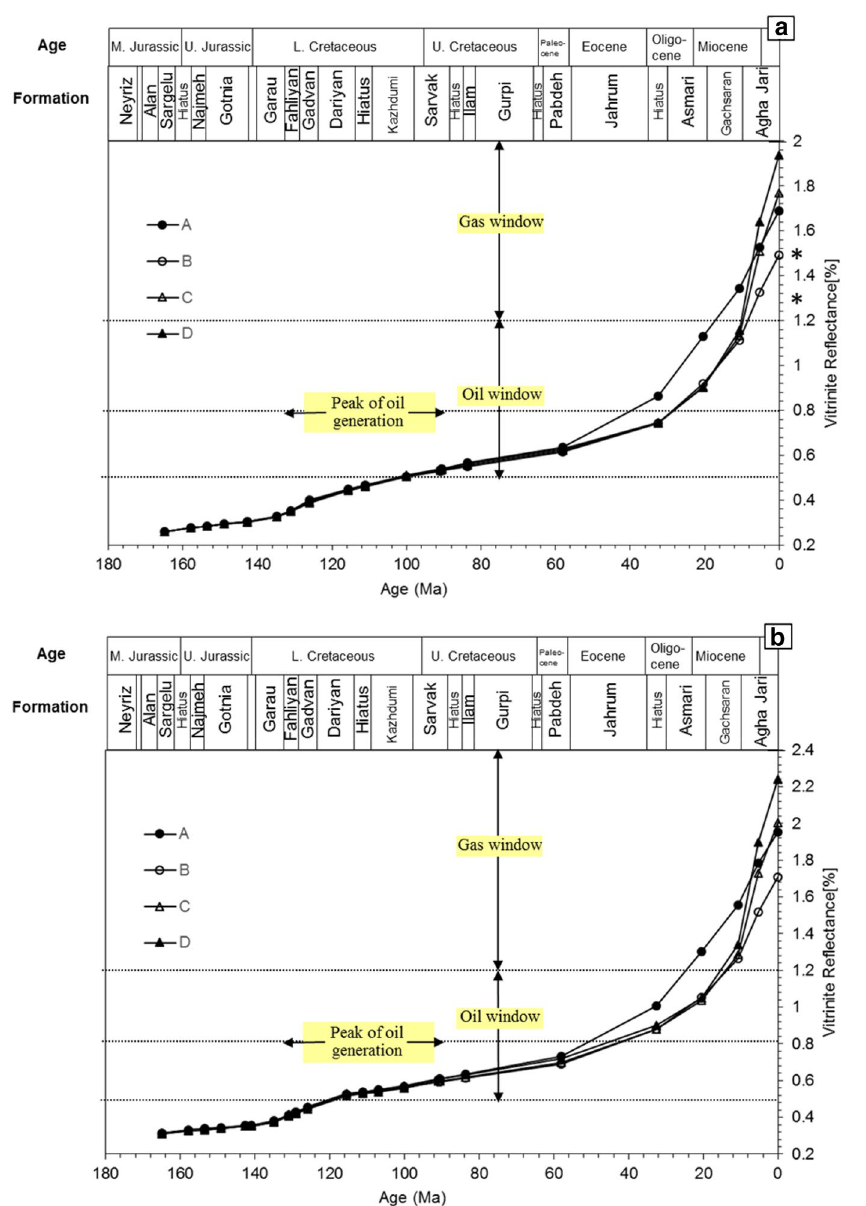
Fig. 15 Maturity history of the Sargelu ( a ) and Neyriz ( b ) source rocks for Wells A, B, C, and D (*measured vitrinite reflectance data from Well B